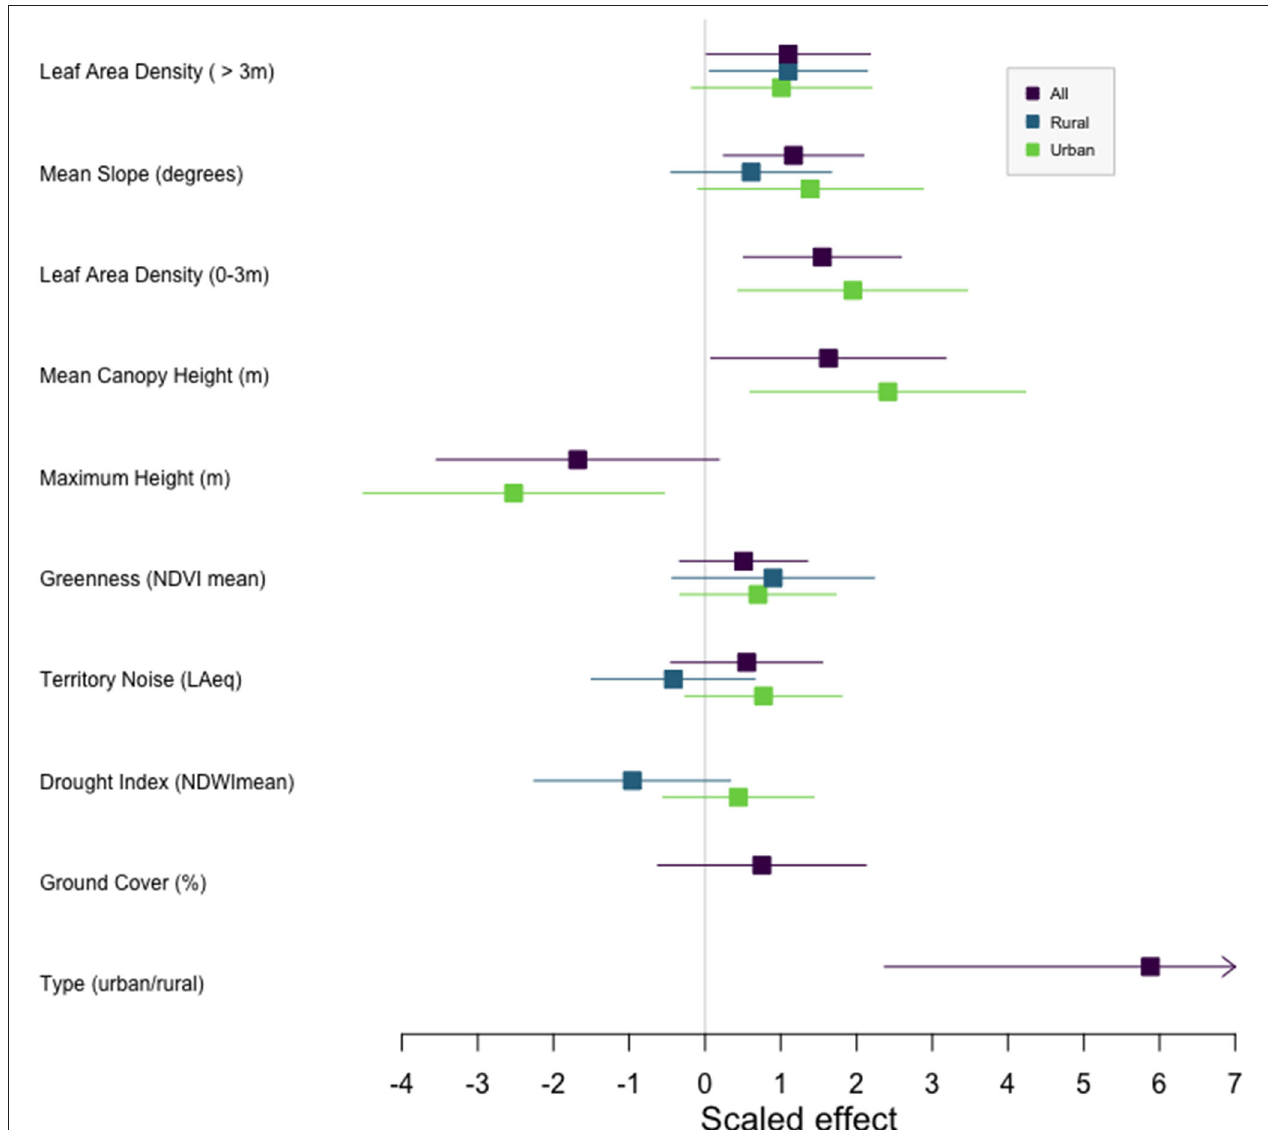
FIGURE 3 | Effects plot for the model average of 13 candidate models across urban and rural locations (All), 10 candidate models within urban areas (Urban), and 7 candidate models within rural areas (Rural). Variables to the left of zero have a negative effect on vocal deviation, and are associated with higher performance songs, while variables to the right have a positive effect on vocal deviation, indicating an association with lower performance songs. Boxes denote mean and lines denote 95% confidence